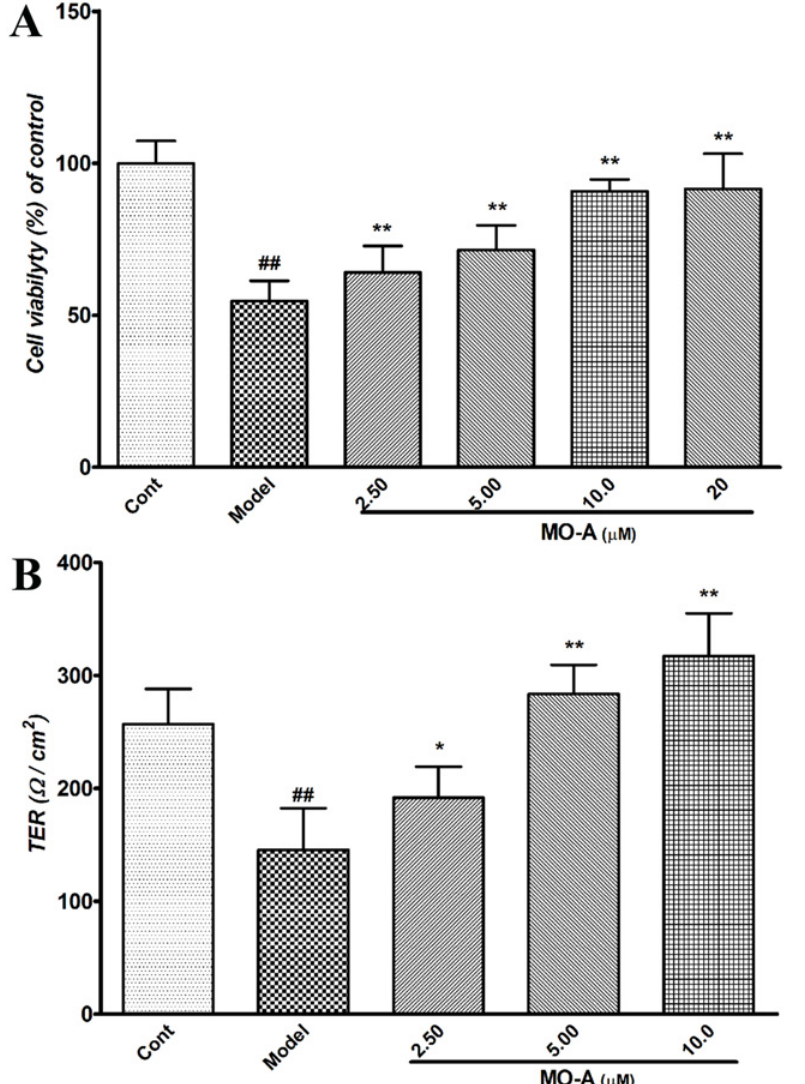
Fig 3. Effect of MO-A on BBB disruption. (A) cell viability of OGD/R-induced bEnd.3 cell injury was determined with MTT assay; (B) Effect of MO-A on hypoxic BBB damage in vitro ; Data are given as mean ± S.D. (n = 3); # P < 0.05 and ## P < 0.01 vs . sham group by Student ’ s t -test statistical analysis; * P < 0.05 and ** P < 0.01 vs . MCAO model group by one-way ANOVA statistical